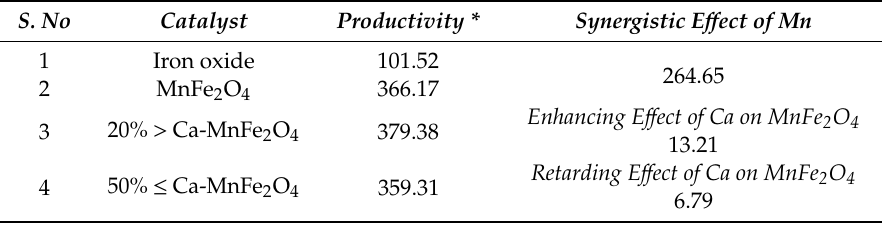
Table 2. Catalytic activity of catalysts for the oxidation of a CH.